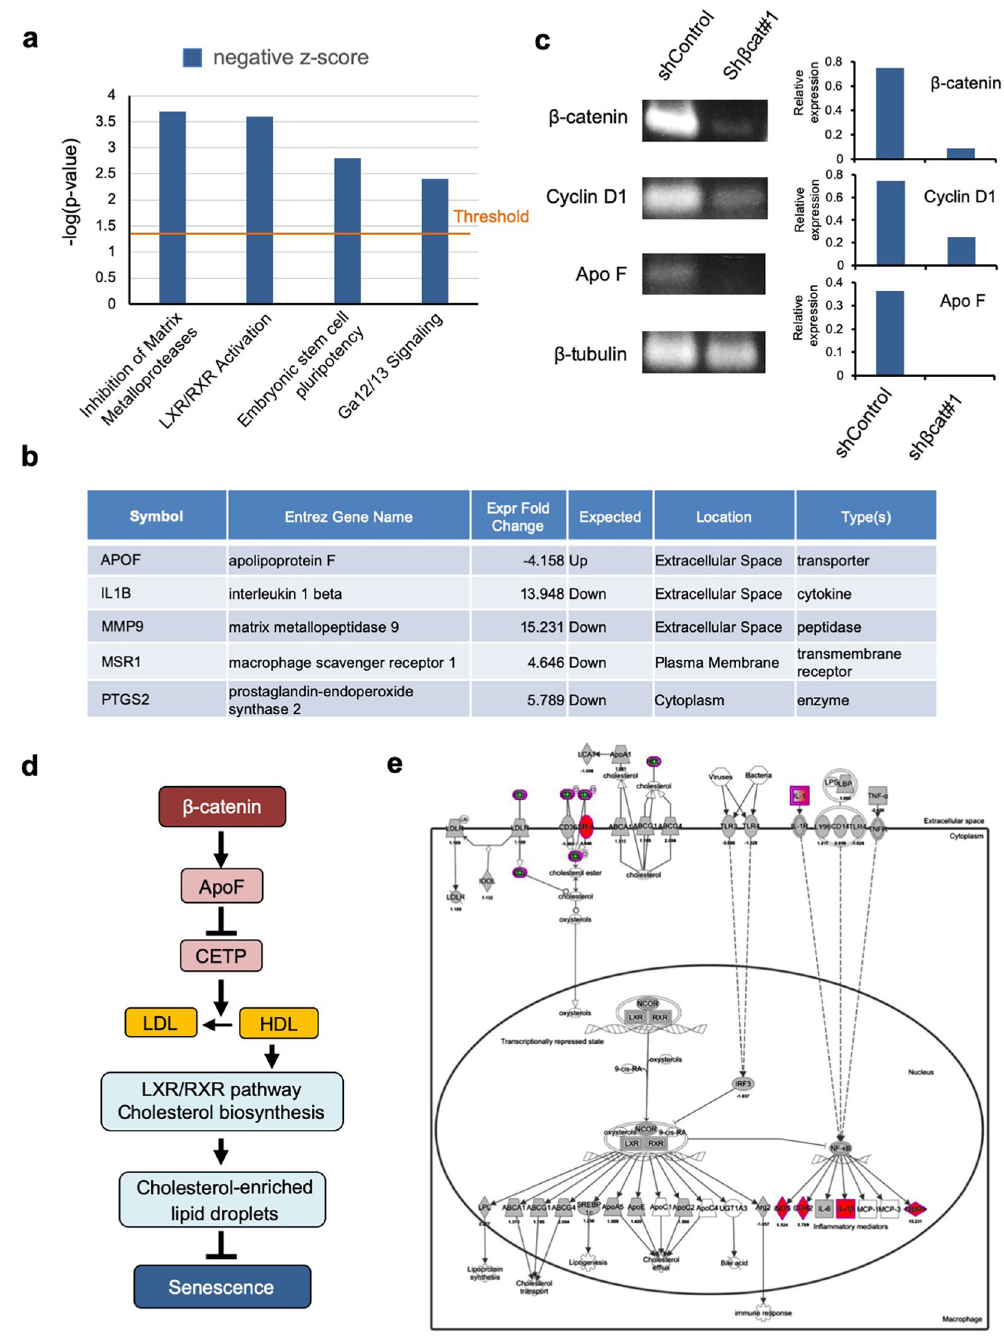
Fig. 5 Association between β -catenin abundance and LXR/RXR activation in NSFs. a Ingenuity Pathway Analysis (IPA) results showing pathways that were signi fi cantly affected (>4-fold-change) by β -catenin knockdown in NSFs. b Genes showing signi fi cant expression changes in β -catenin knockdown conditions. c Analysis of target genes regulated by β -catenin in NSFs by RT-PCR (left panels). Quantitative data are also shown (right-most graphs). d Schematic diagram illustrating potential links between β -catenin, ApoF, the LXR/RXR pathway, cholesterol biosynthesis and metabolism, lipid droplets, and senescence in NMR cells. e Schematic IPA diagrams showing LXR/RXR-dependent changes in gene expression potentiated by β -catenin